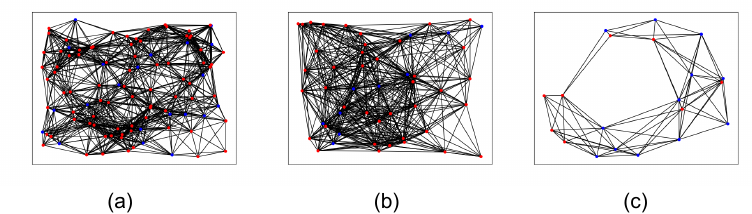
Figure 13. Three examples of random red–blue visibility graphs. Graph ( a ) has 100 nodes and 0.3 edge density. Graph ( b ) has 50 nodes and 0.5 edge density. Graph ( c ) has only 20 nodes, which is useful for quickly testing the